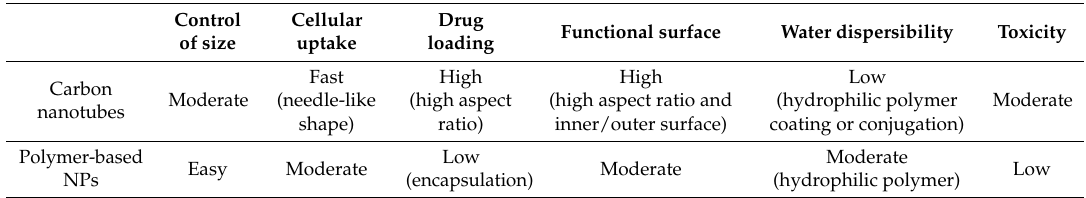
Table 2. Comparisons of material-based features between CNTs and polymer-based nanoparticles